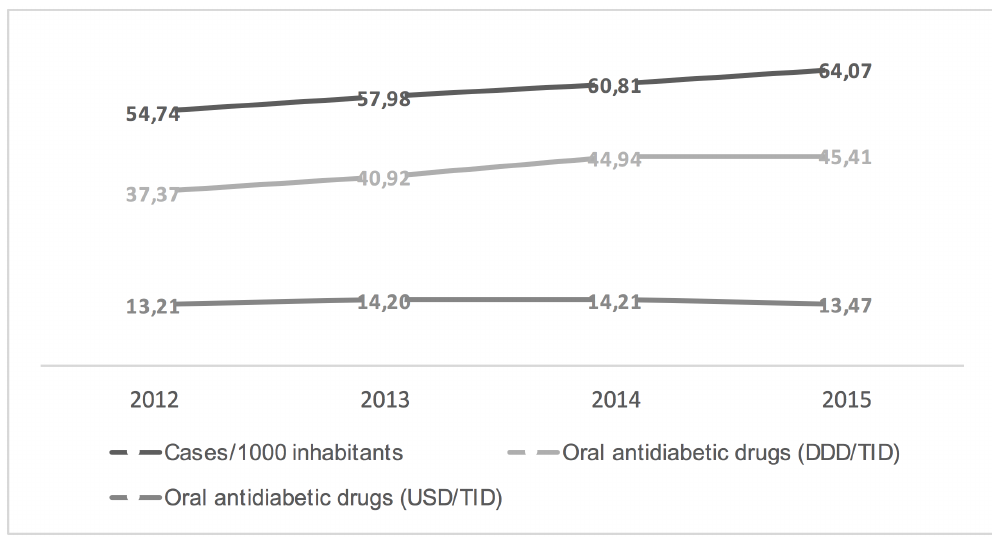
Fig 3. Trends in the diabetes mellitus morbidity (casesper 1000inhabitants), oral antidiabetic drugs consumption (DDD/TID) and costs (USD/TID) in Poland, 2012–2015.